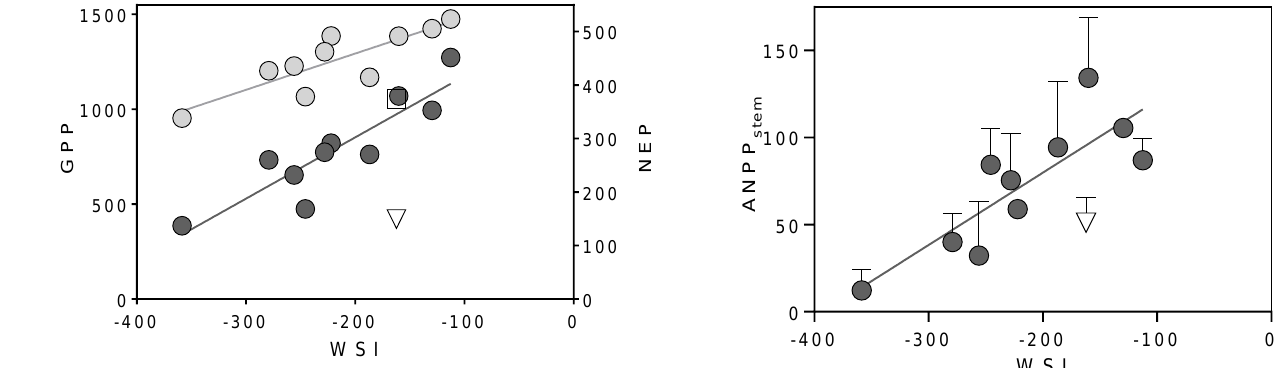
Figure 4. Ordinary least-square regression line between the WSI and the net production of stems (error bars are standard deviation). WSI is expressed in MPa day and ANPP stem in gCm − 2 yr − 1 . Data from 2005 that were not used in the analysis were also plotted (empty